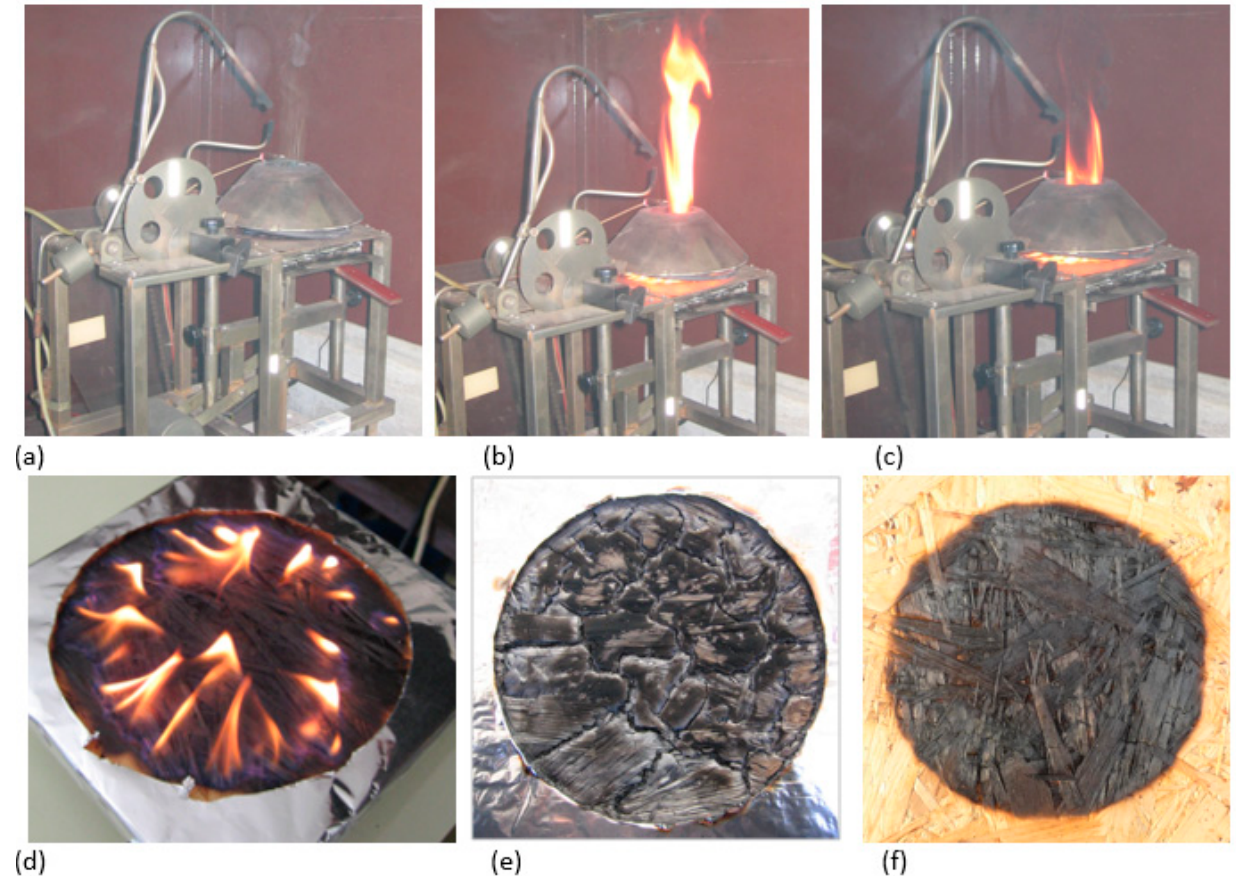
Figure 4. Demonstration of the course of burning of oriented strand boards (OSBs) after their ignition by radiant heat ( a ) ignition (100 s); ( b ) burning time of 160 s; and ( c ) 300 s. ( d ) A demonstration of the combustion process by 44 kW.m − 2 . ( e ) A sample selected from the measuring device; specific distance of 12 mm, time of ignition of 57 s and density heat flux of 50 kW.m − 2 . ( f ) Cooled sample 10 min after the experiment; sample thickness of 15 mm and ignition time of 108 s, 44 kW.m − 2 .